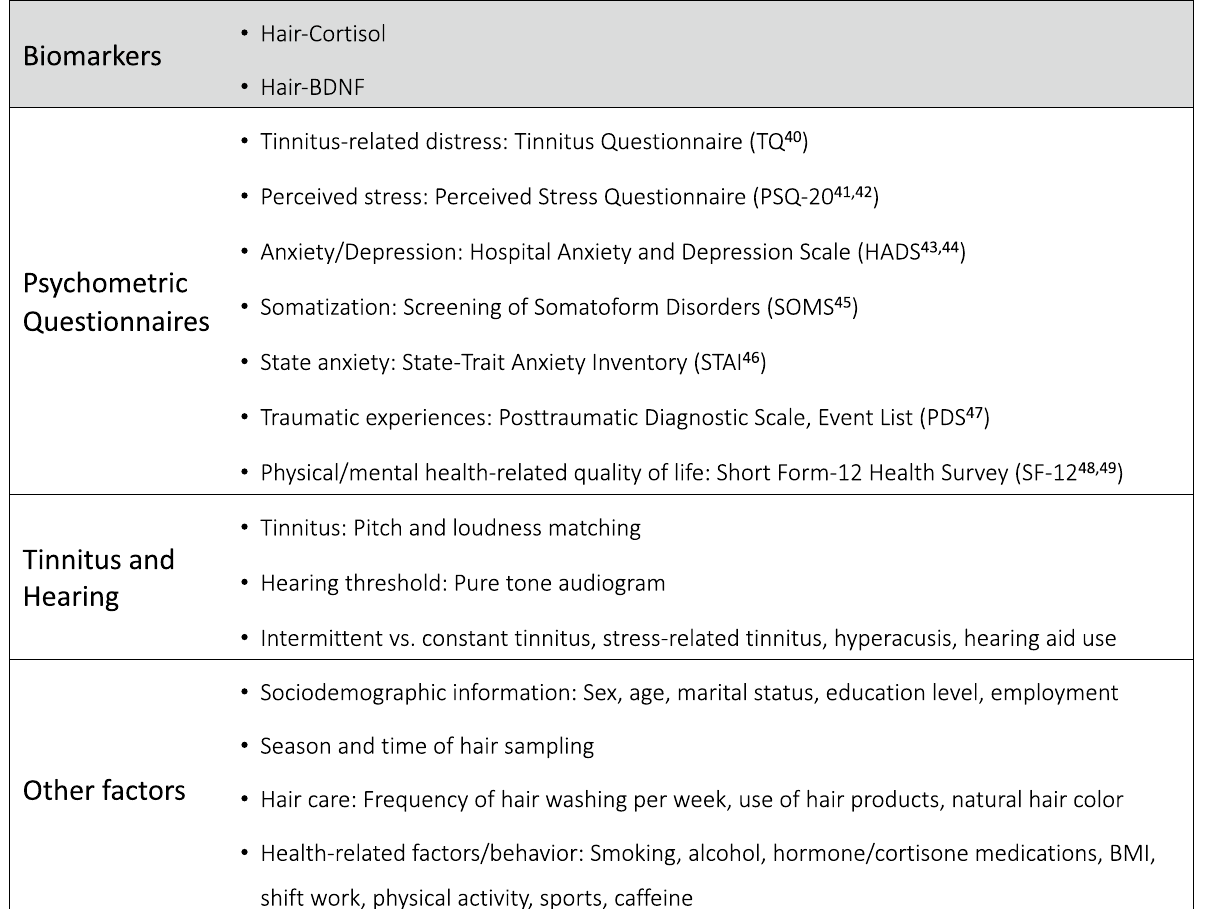
Figure 1. Overview of included study variables. Biomarkers (cortisol and BDNF measured in hair) were investigated as outcome variables while all other variables (psychometric questionnaires, tinnitus and hearing, covariates) were used as